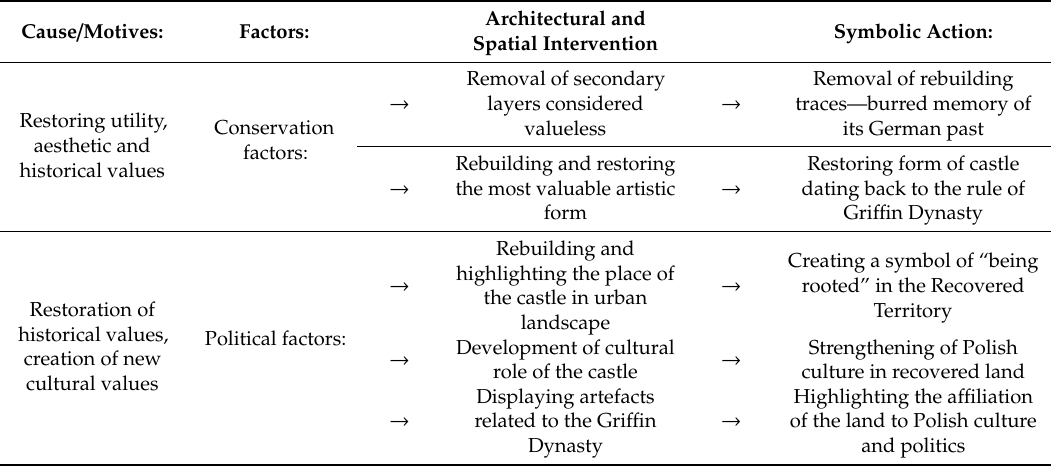
Table 2. Factors that contributed to the transformation of ducal castles in the Polish